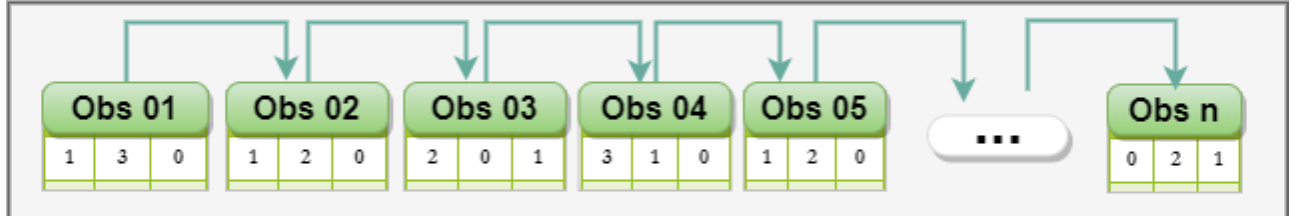
Figure 11. Configuration used to evaluate stability of individuals’ social